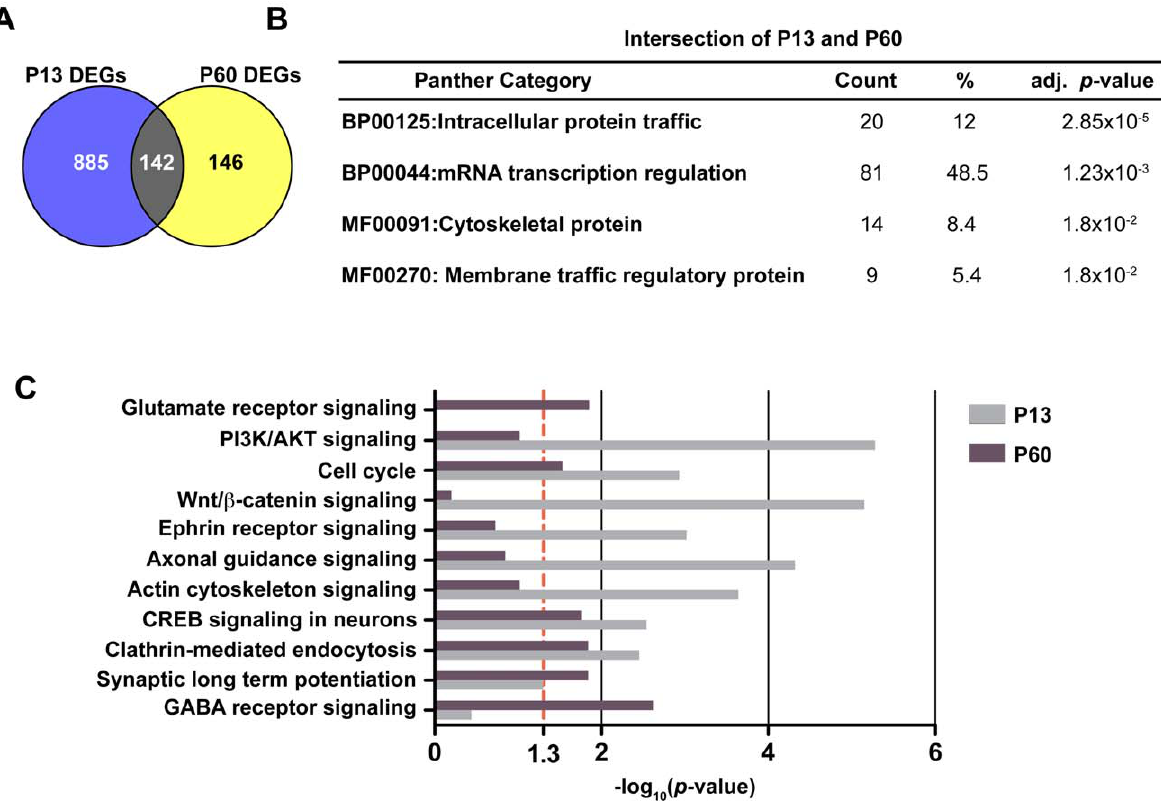
Figure 2. Functional categories of genes significantly over-represented in a 9 2 / 2 . ( A ) Venn diagram depicting the overlap among differentially expressed genes (DEGs) between P13 and P60. The intersection of differentially expressed genes between wild type and a 9 2 / 2 consists of 142 genes. (B) Over-represented classes among these 142 genes are shown (DAVID, BH-adjusted p -value , 0.05). (C) Comparative enrichment of functional categories (Ingenuity database; 2 log 10 (enrichment p -value)) between P13 and P60 are indicated; larger values indicate higher significance. The dotted line at 1.3 corresponds to p -values of 0.05 on this scale.